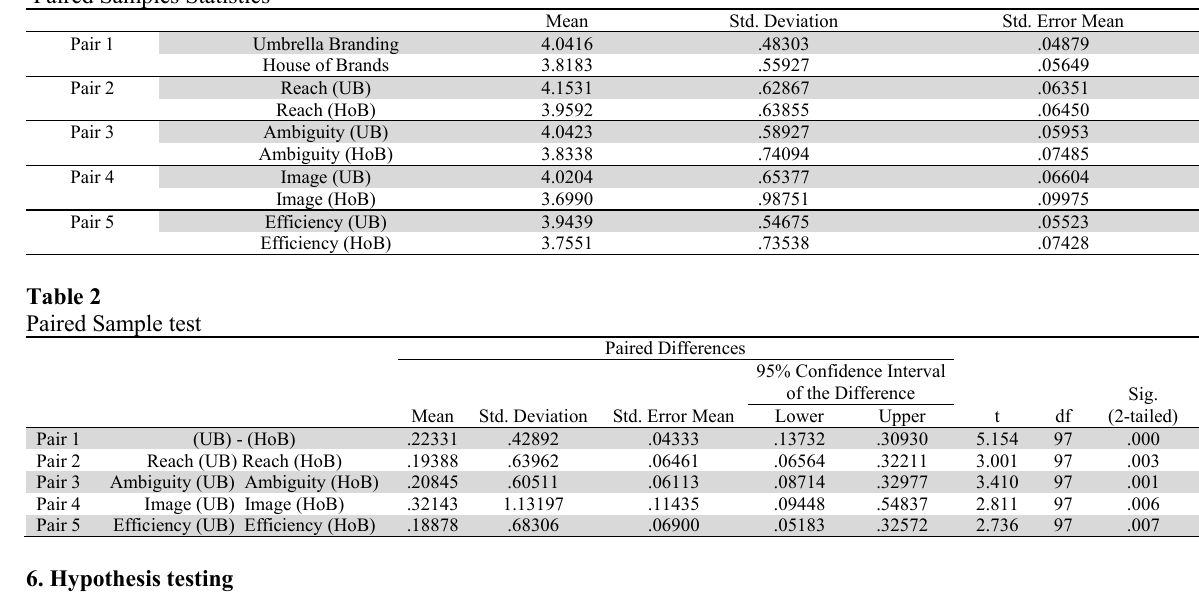
Paired Samples Statistics